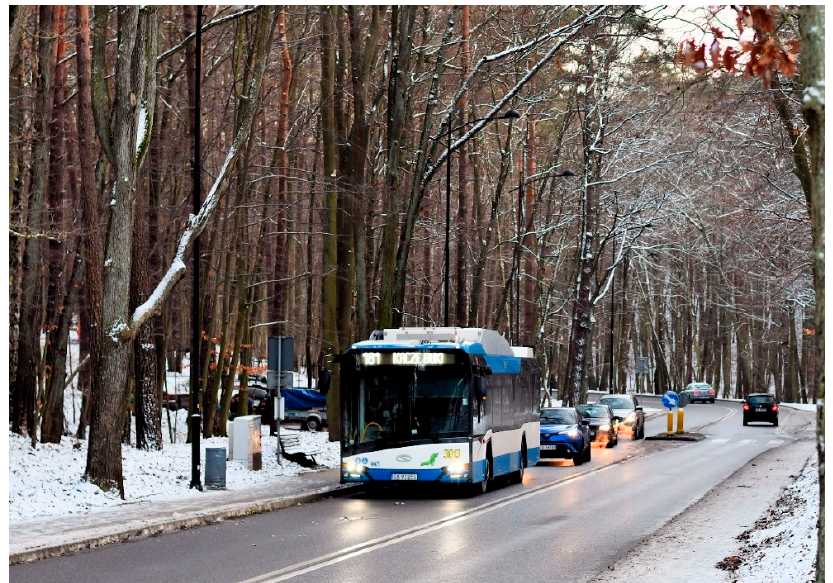
Figure 4. A trolleybus running on bus line 181 using battery power in Sopot (photo taken by K.